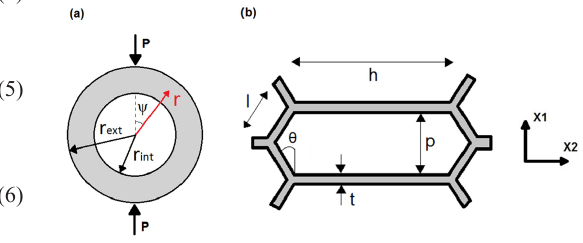
Figure 2. (a) Geometric parameters of the O-ring test used by Kranendonk’s equations (2-11) and (b) geometric parameters of a honeycomb cell used by Gibson’s equations